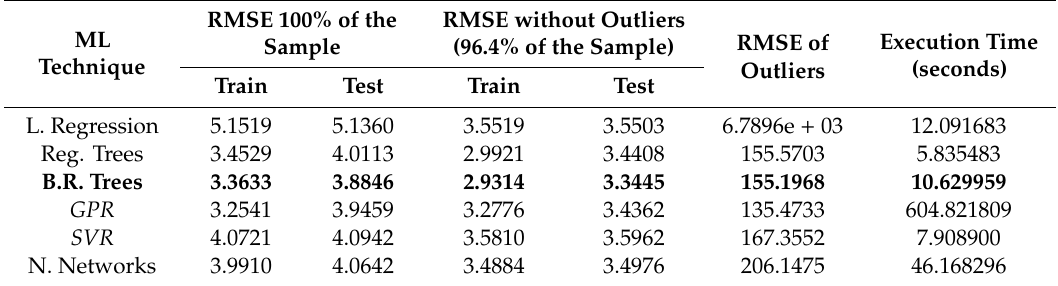
Table 8. BMI-CTDI VOL results for men’s Abdomen & Pelvis protocol.